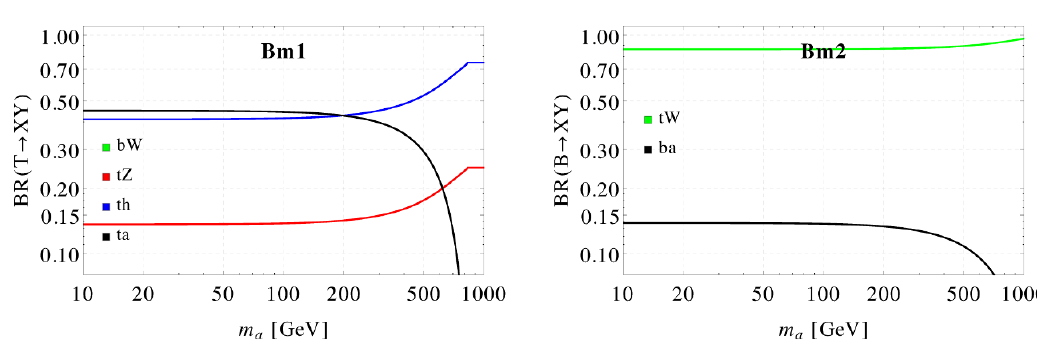
Figure 1 . BRs of T (left) and B (right) as a function of mass m a respectively in two di(cid:11)erent benchmark models Bm1 and Bm2 introduced in section 3. For T , a decay into bW is allowed, but suppressed in the chosen benchmark point